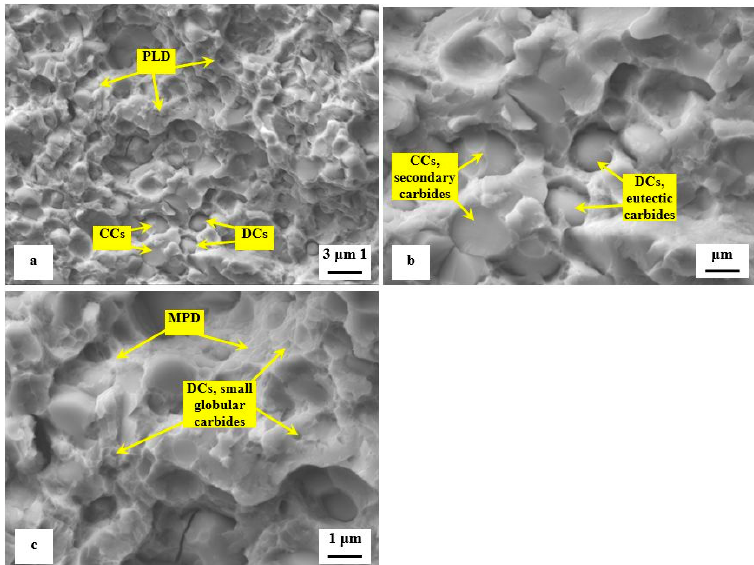
Figure 13. SEM images showing details of fracture propagation in sub-zero treated and subsequently tempered (at 530 °C) fracture toughness specimen, ( a ) detailed image showing the crack propagation in the matrix and the three main carbides including their role in fracture propagation, (CCs—cleaved carbides, DCs—decohesive carbides, PLD—plastic deformation in the matrix), ( b ) high-magnification image showing cleaved M 7 C 3 (CCs, secondary carbide), and decohesive particles that belong to eutectic carbides (DCs, eutectic carbides), and ( c ) high-magnification image showing micro-plastic deformation of the matrix (MPD) and small dimples resulting from the extraction of small globular carbides.